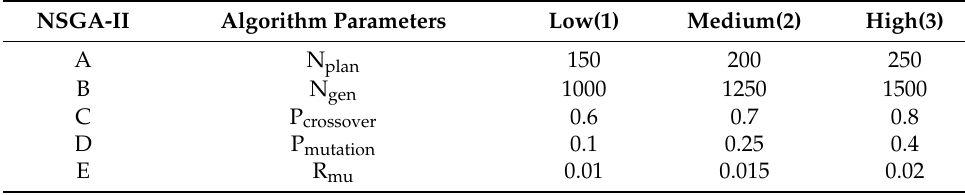
Table 1. Tuning experiment of the five factors with three levels (NSGA-II).